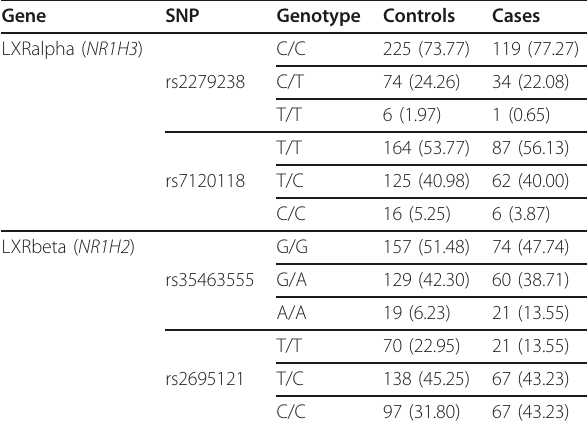
Table 4 Genotypic counts and frequencies of the studied polymorphisms